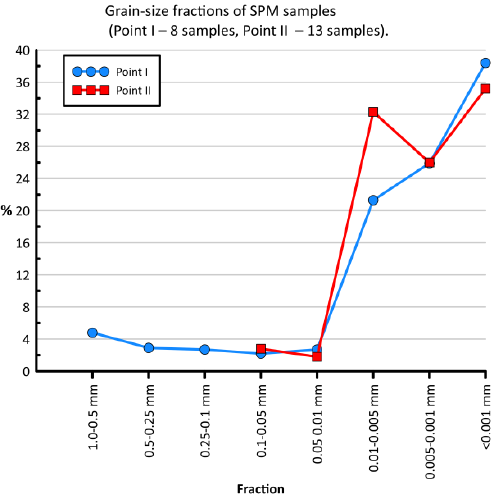
Figure 5. The content of grain size fractions in samplings from point I and II. The data show that pelitic fractions (<0.01 mm) predominate in the Severnaya Dvina suspended matter (85.7% on average at point I and 93.4% at point II, percentages of subcolloidal fraction are 38.4% and 35.2%, respectively). The share of silt fraction (0.01–0.1 mm) is fractions (0.1–1.0 mm): while at point I, 0.1–0.25 mm, 0.25–0.5 mm, and 0.5–1.0 mm fractions